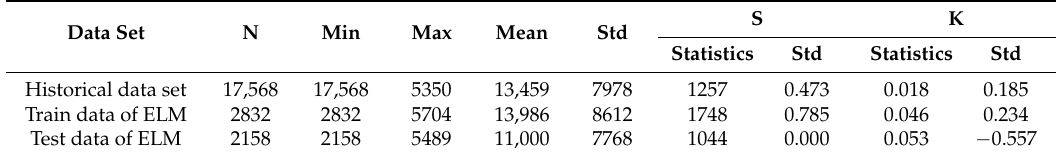
Table 1. Statistical parameters in each data